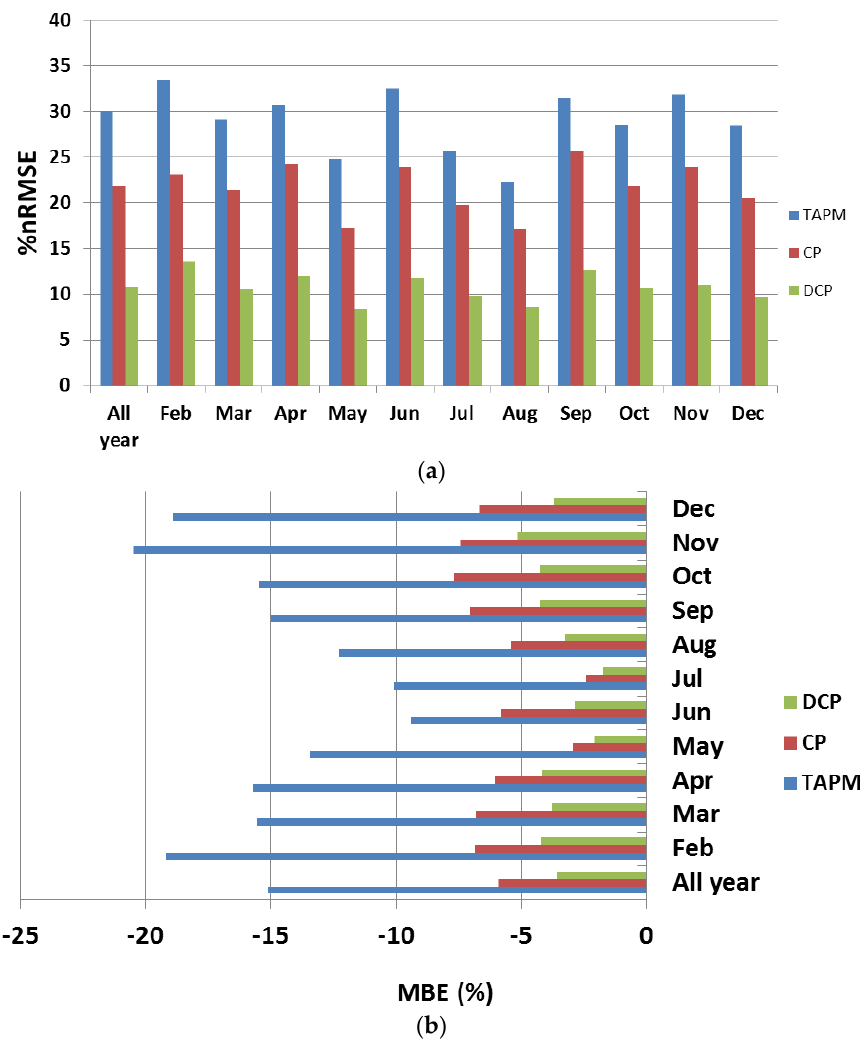
Figure 7. ( a ) The % nRMSE with respect to the average observations for TAPM, CP, and DCP for each month and all year, ( b ) As for ( a ) but with respect to MBE.